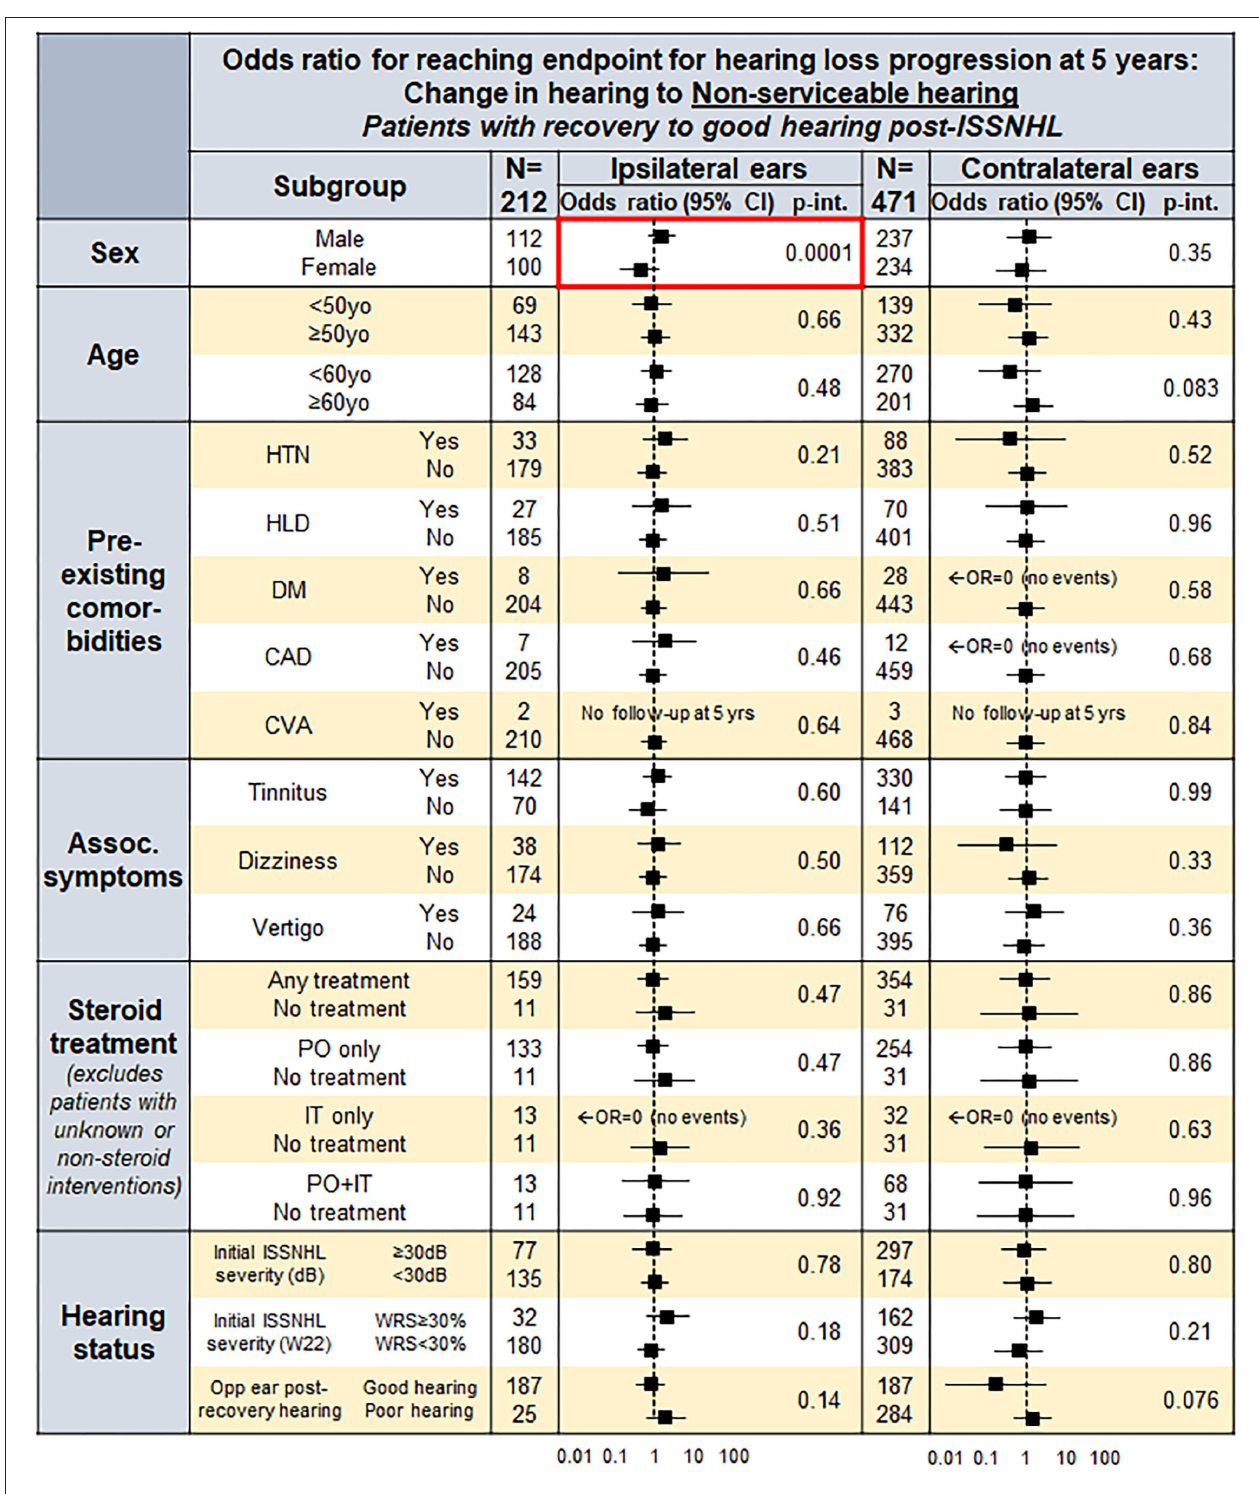
FIGURE 4 | A forest plot for odds ratio ( OR ) to reach endpoint by endpoint non-serviceable hearing in both the ISSNHL-ipsilateral and contralateral ears at 5 years, in the patients with post-ISSNHL recovery to good hearing in the respective ear.